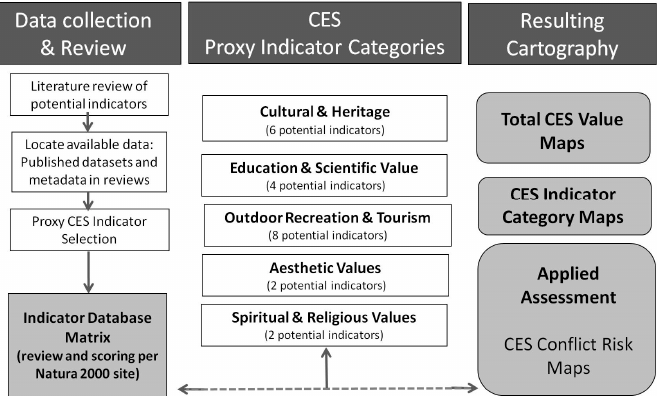
Figure 1. Schematic representation of the cultural ecosystem services (CES) rapid assessment approach.